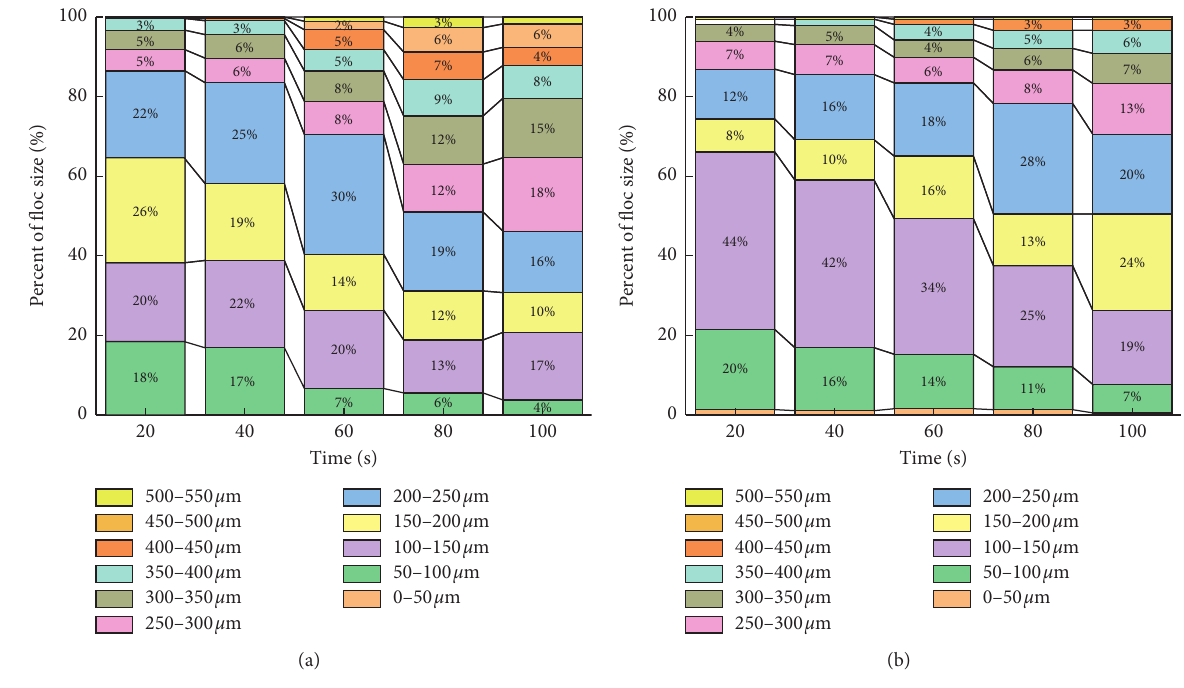
Figure 2: The floc size distribution for the (a)MCPAM flocculation and (b)CPAM flocculation.